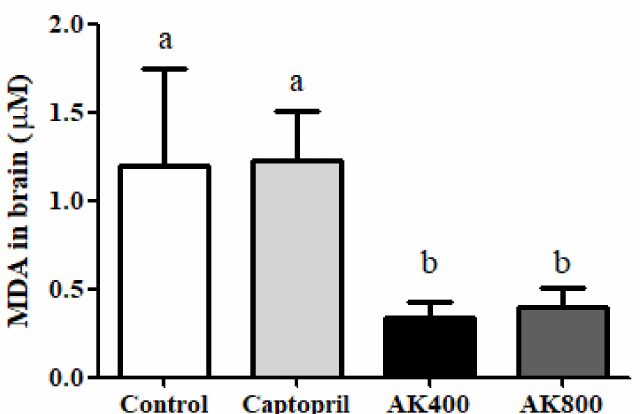
Figure 1. Thiobarbituric acid-reactive substance (TBARS) concentration ( µ moL malondialdehyde; MDA) in the spontaneously hypertensive rat (SHR) brain. The groups were the control (distilled water), captopril (20 mg / kg body weight), AK3K400 (400 mg / kg body weight), and AK3K800 (800 mg / kg body weight). Data are presented as the mean ± standard deviation (SD). a-b Di ff erent letters indicate statistically significant di ff erences ( p < 0.05) in the di ff erent